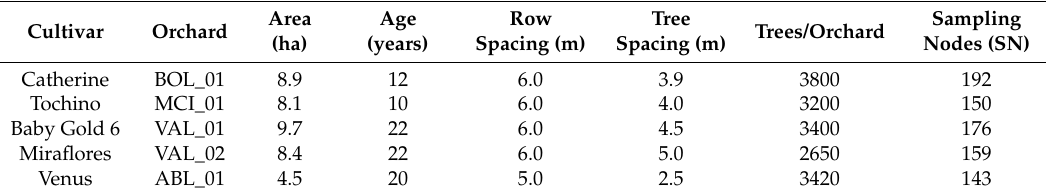
Table 1. Description of the characteristics of the five orchards used in the study.